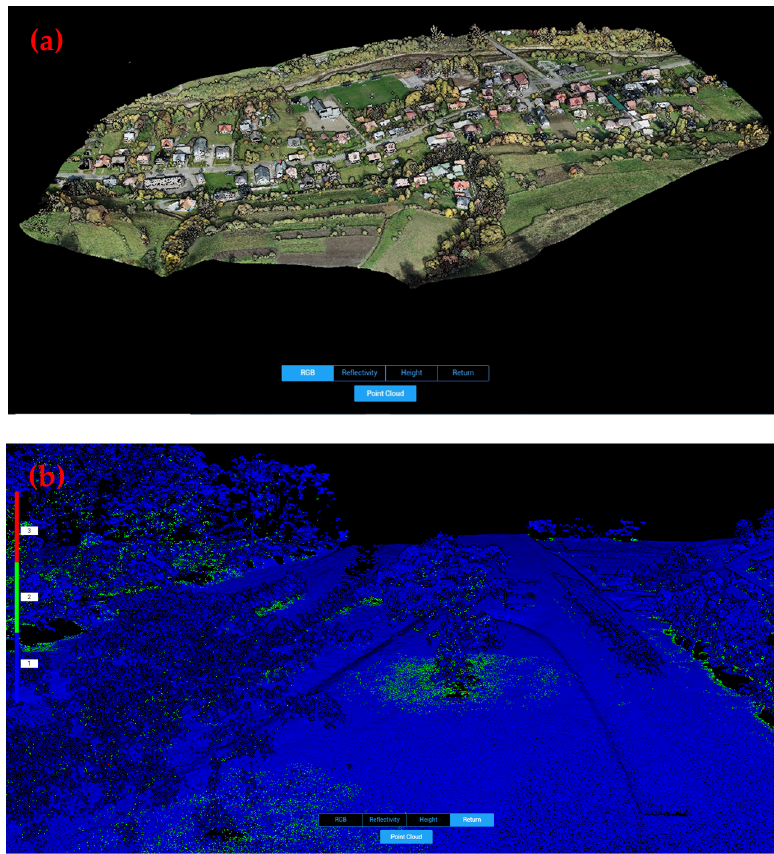
Figure 6. A point cloud generated in the DJI Terra software, ( a ) the entire study area in the RGB form, ( b ) a fragment with the registration of the second and third reflections under the vegetation.